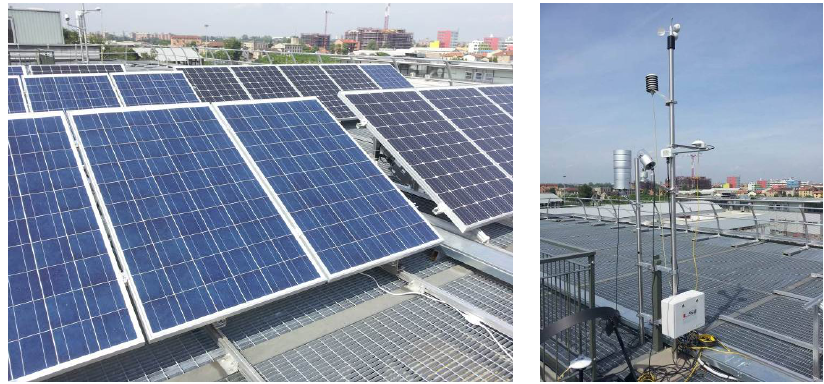
Figure 14. ( a ) Solar Tech Lab of the Politecnico di Milano, Italy; ( b ) Weather station of the Solar Tech Lab.